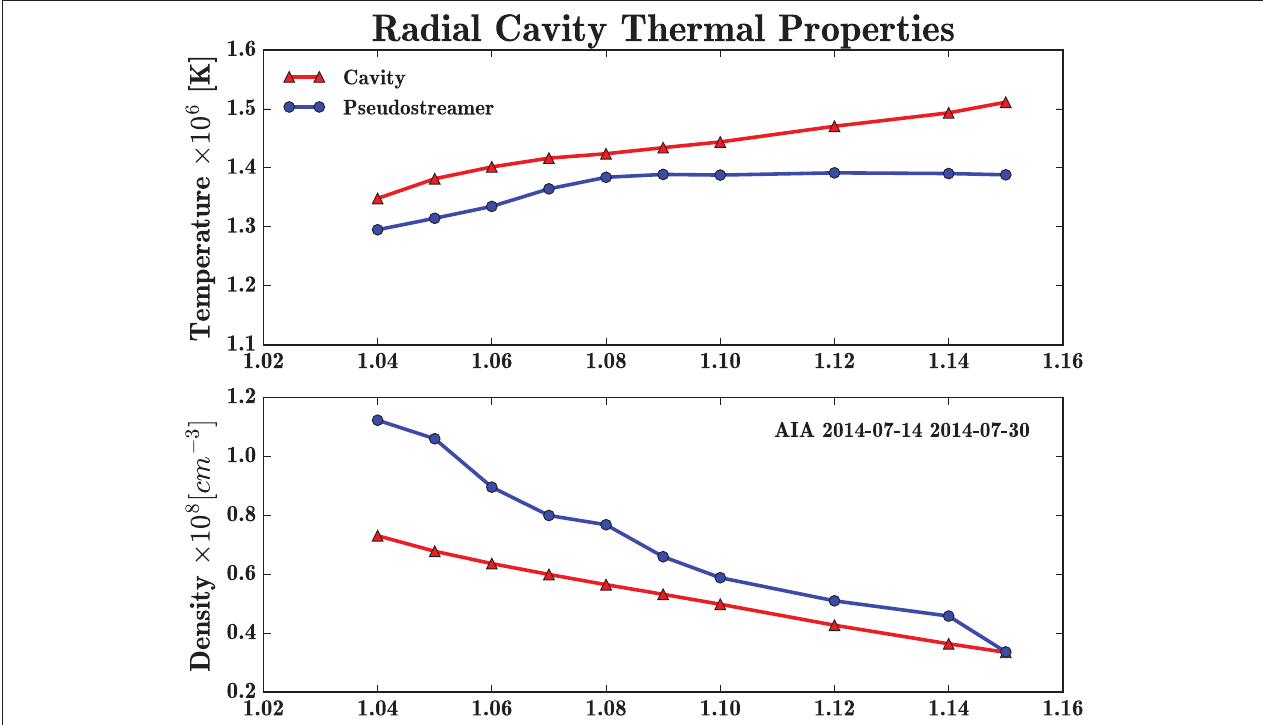
FIGURE 9 | Radial evolution of the temperature and density with respect to the altitude in both the cavity and the pseudostreamer for the July 14th reconstruction. The temperatures are slightly higher in the cavity, while the density is clearly lower, especially at low heights.